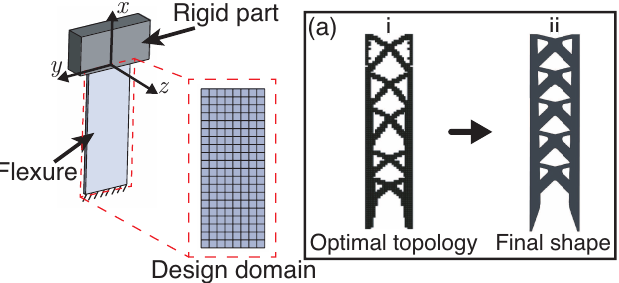
Figure 17. Schematic description of the Topology Optimization process to design the optimal configura- tion of SATFJ using a 2D design domain based on the geometry of blade flexures. ( a ) Optimal design obtained in [52] i-optimal topology and ii-final shape (reprinted with permission from [52]. 2019, Elsevier).